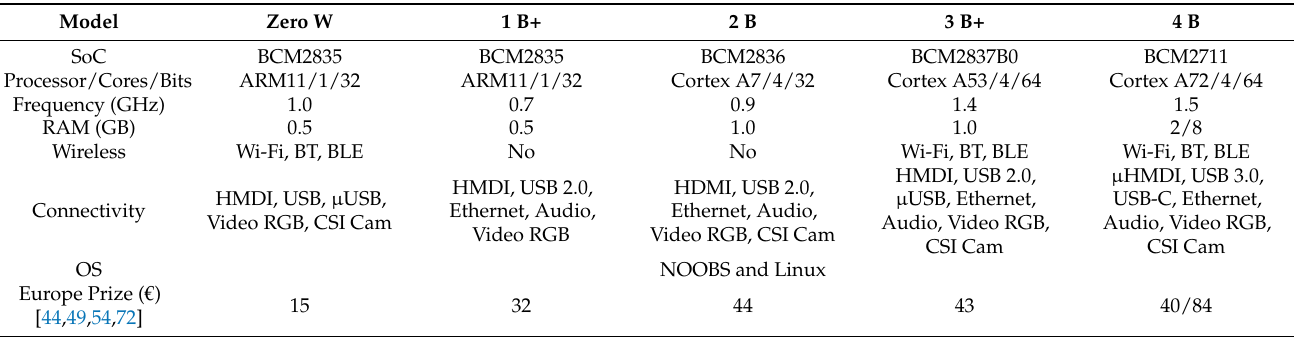
Table 3. The SBC Raspberry PI Model B family [71].